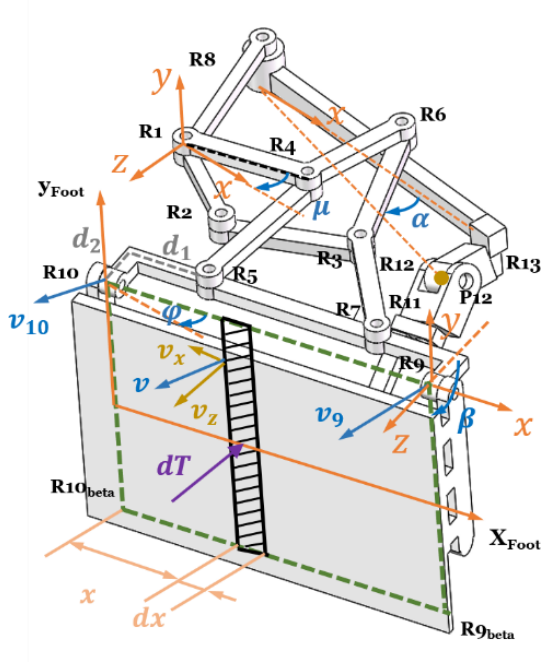
Figure 8. The schematic of generated force on the hindlimbs.